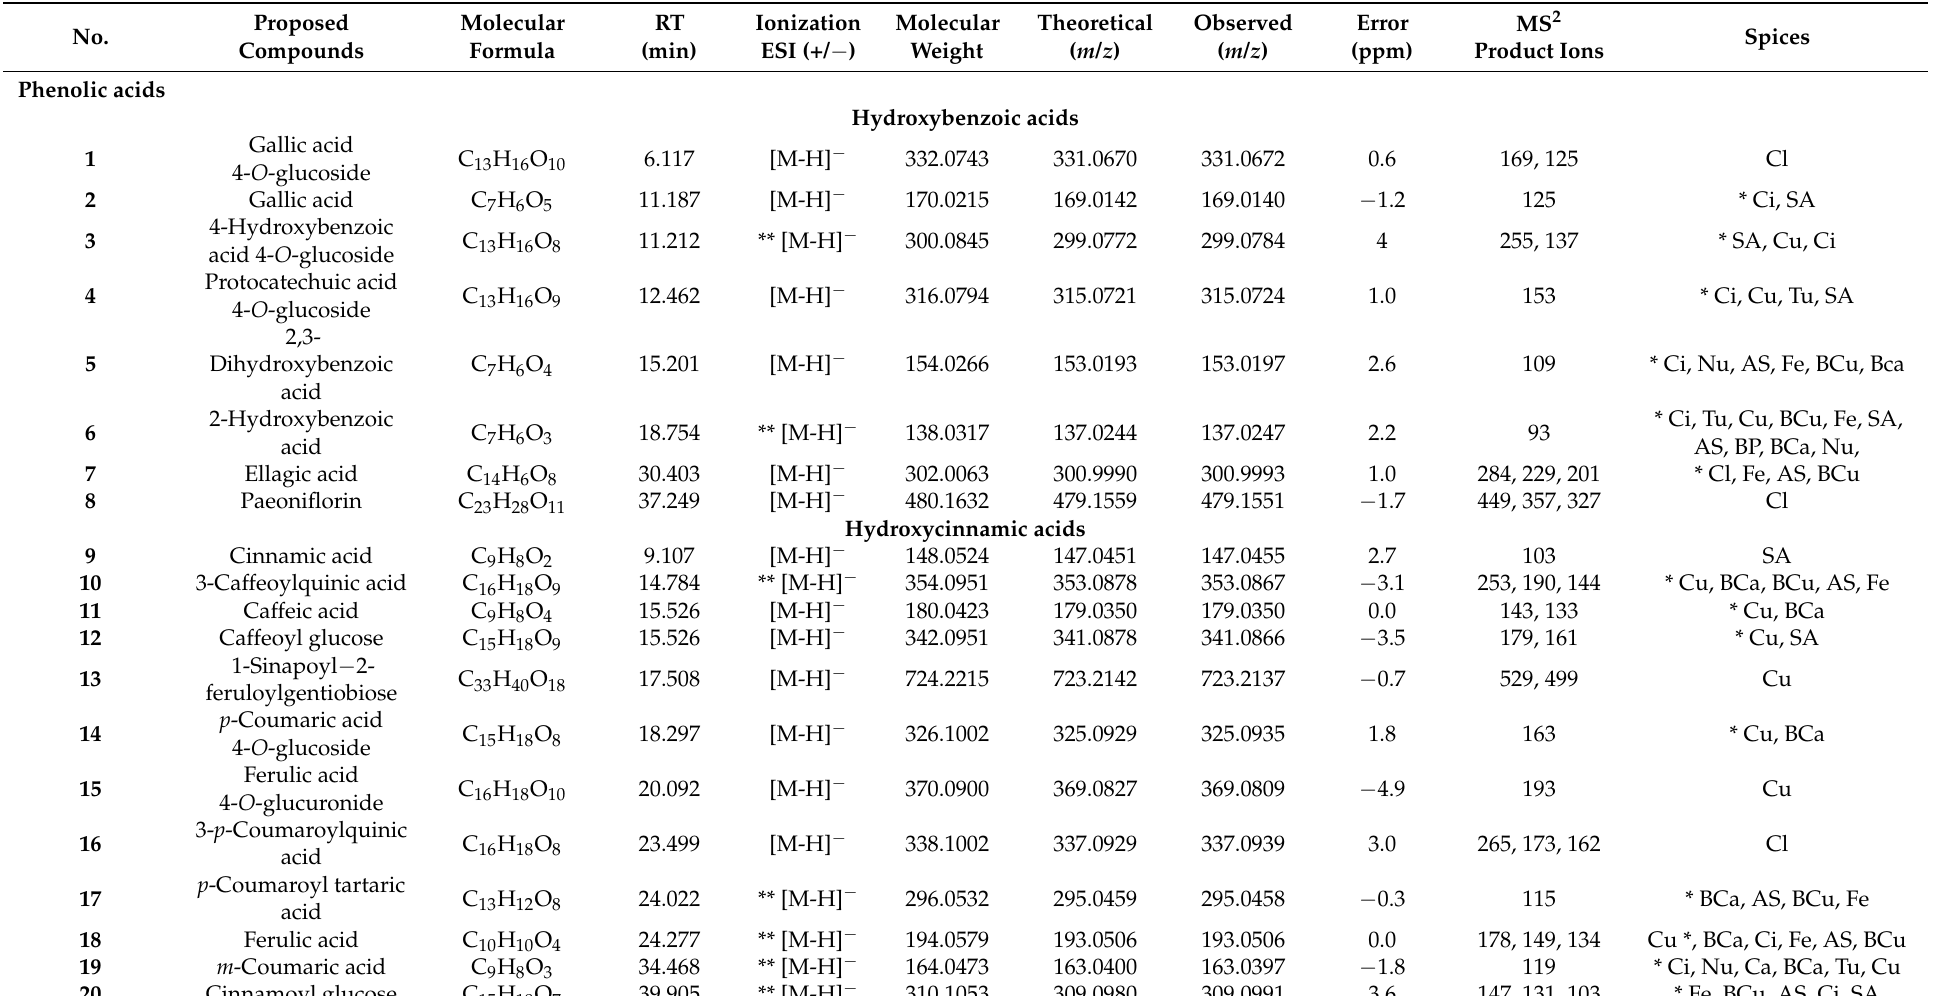
Table 2. Characterization of phenolic compounds from twelve spices through LC-ESI-QTOF-MS 2